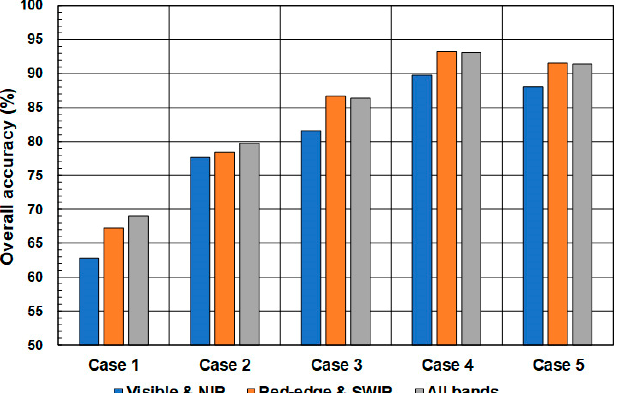
Figure 13. Overall accuracy values of five different incremental classification results for different input combinations. The case numbers can be referred to in Table 7.